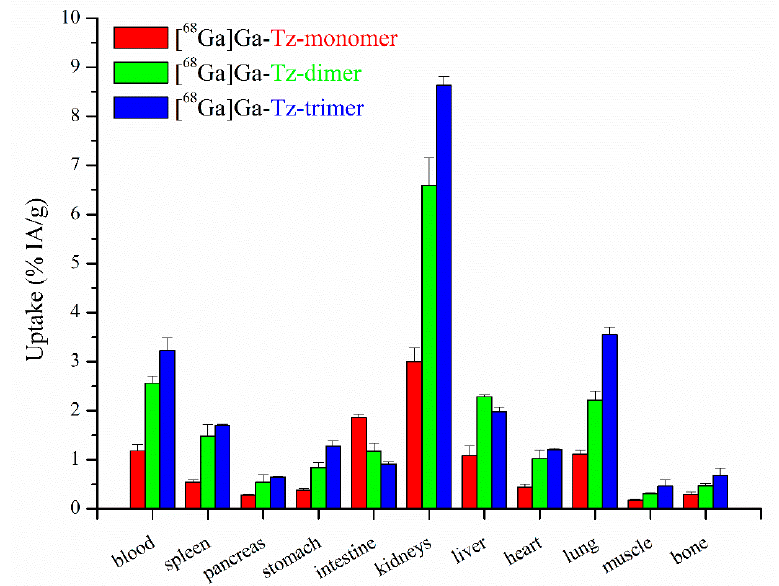
Figure 3. Biodistribution studies of 68 Ga-labelled mono- and multimeric FSC-based pretargeting agents in normal BALB/c mice 1 h p.i. presented as percentage of total injected activity per gram tissue ( n = 3).